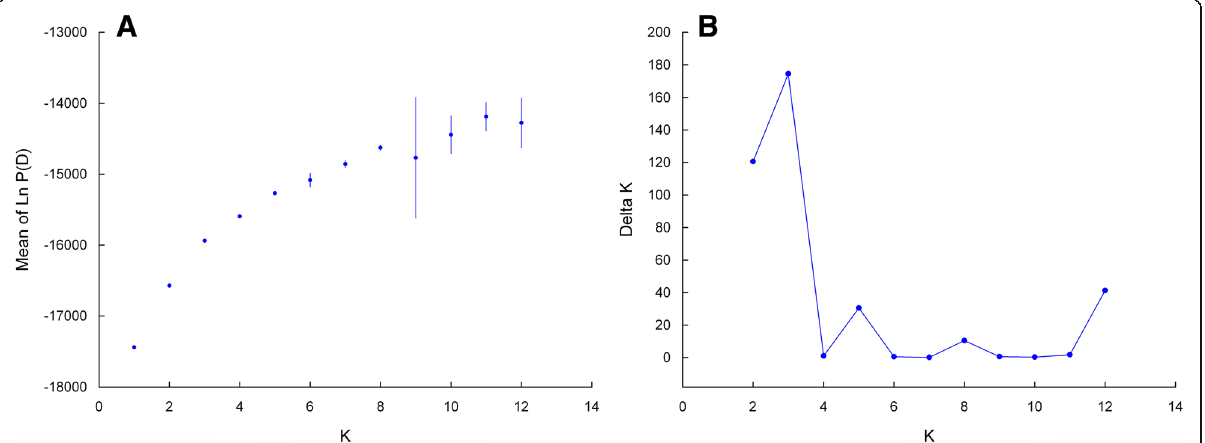
Fig. 1 Analysis of the population structure. The number of group was calculated using STRUCTURE software. a Graph for the log-likelihood. b Graph for Δ K